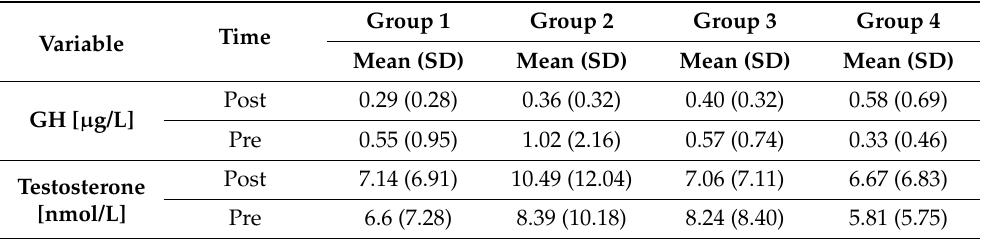
Table 4. Mean and standard deviation of the four groups of hormonal components. GH, growth hormone ( µ g/L); testosterone.